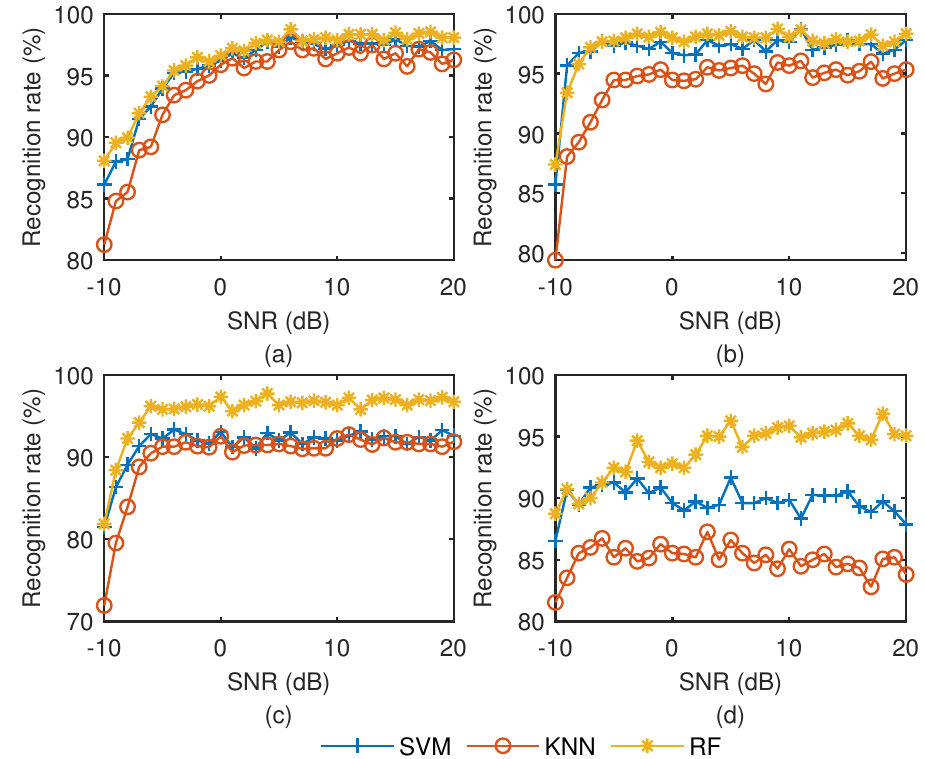
Figure 13. Comparison of the recognition rate under different classifiers. ( a ) OFDM, ( b ) 2FSK, ( c ) 4FSK, and ( d ) 8FSK.